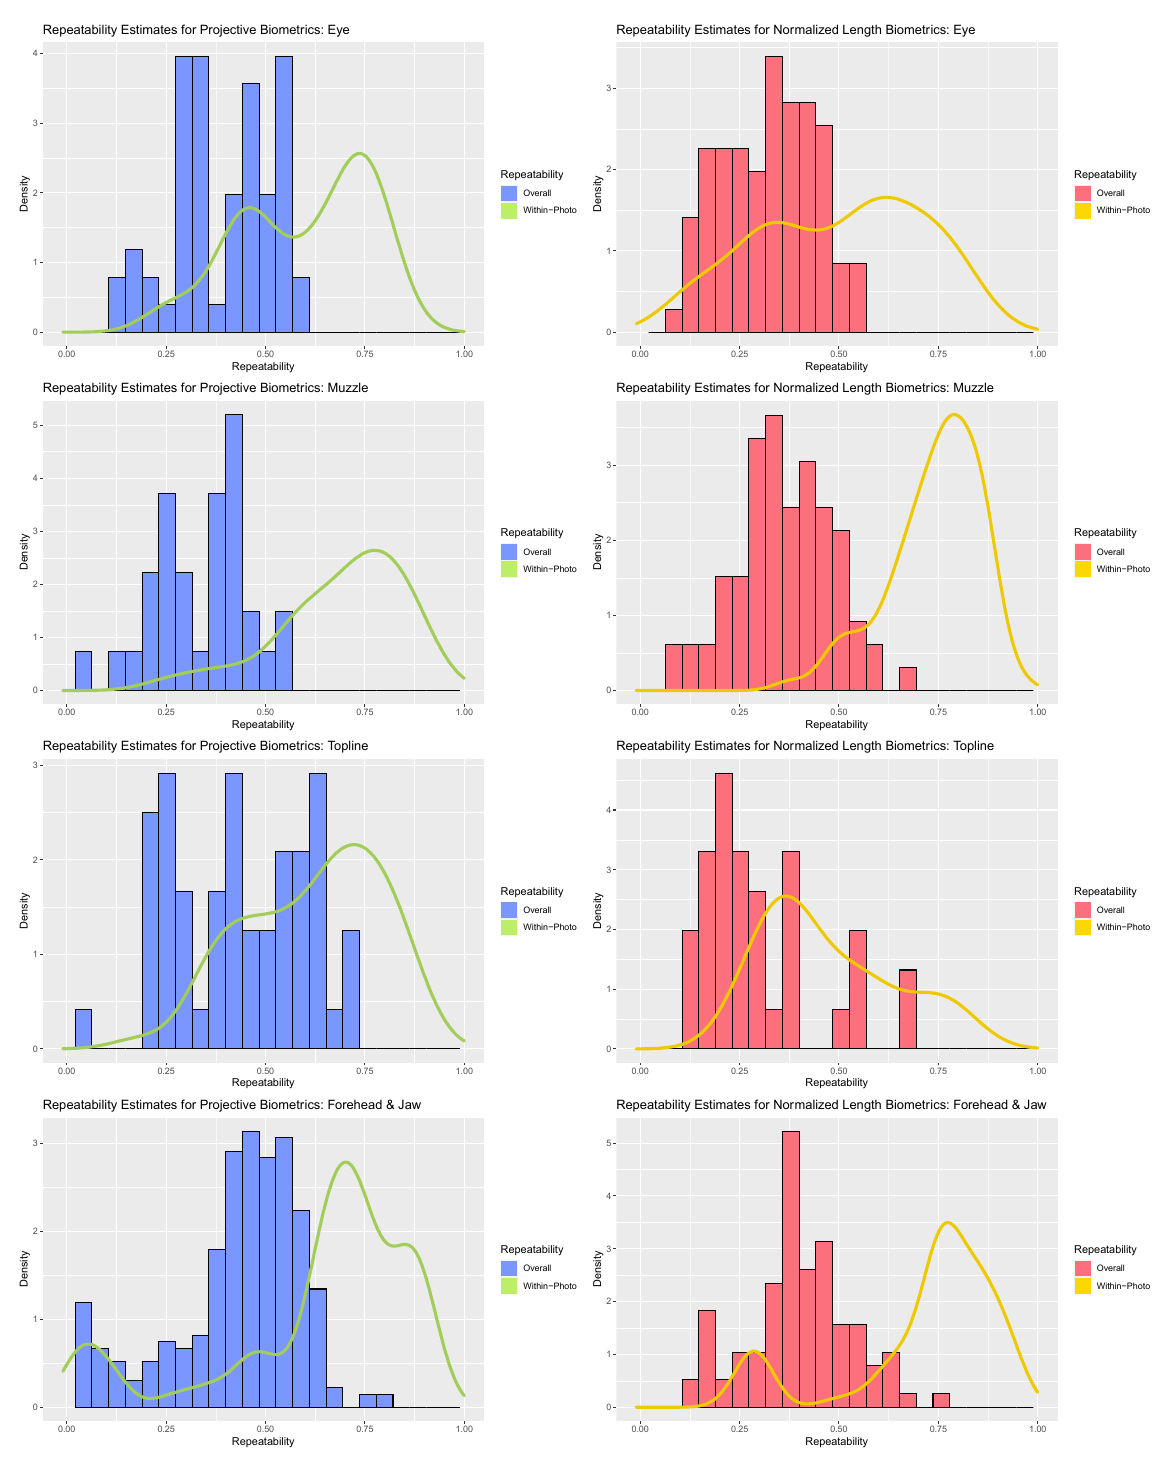
Figure 3. Comparison of within-photo repeatability (density plot) and overall repeatability (his- togram) for normalized length biometrics (red) and projective biometrics (blue) for the four anatomi- cal subregions (from top: eye, muzzle, topline,